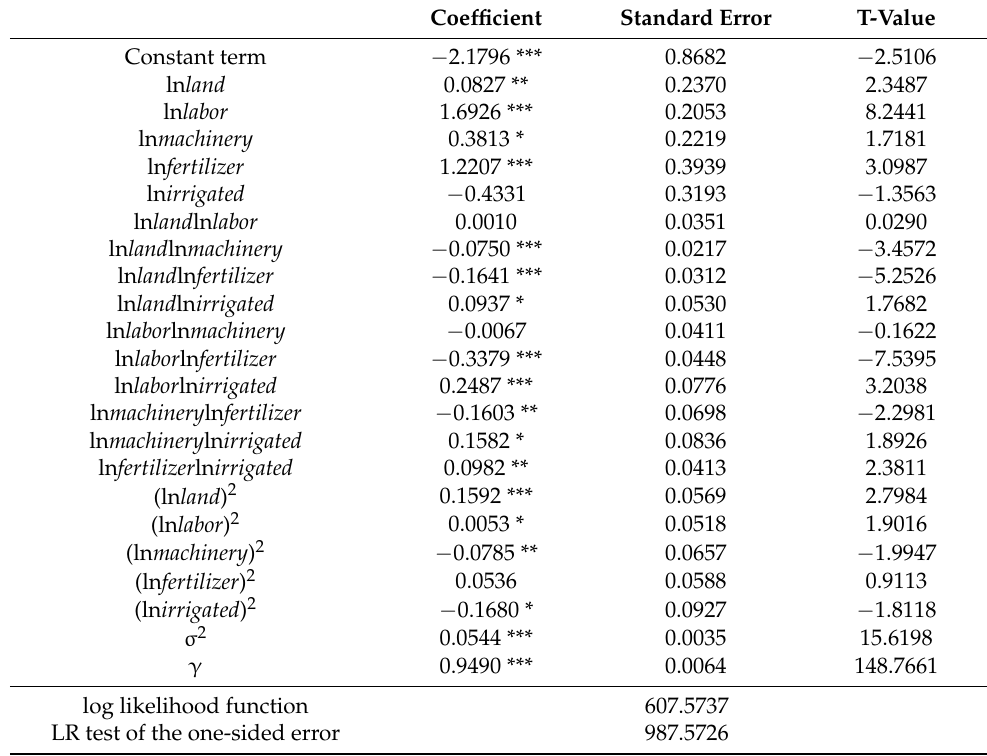
Table 2. Empirical Analysis Results of the Agricultural Technical